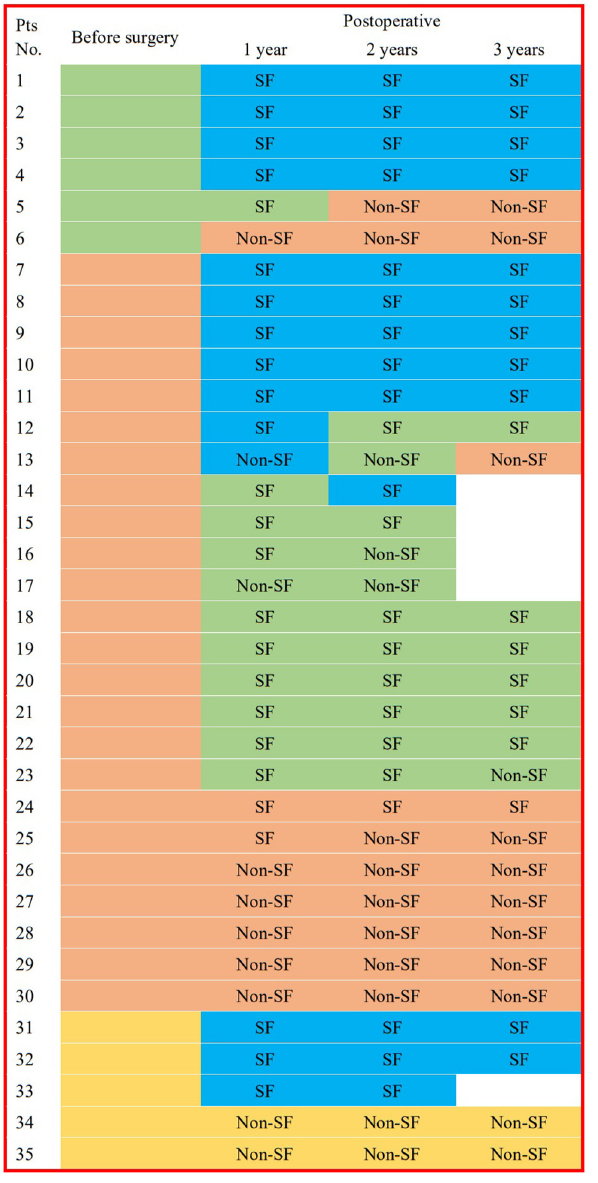
reviewed the recordings. The results of interictal EEG were divided into four groups: non-interictal discharge (IID) (without interictal epileptiform discharges, IIDs) ( Figure 1B ,B3), focal IID (unique unilateral focal IID with or without generalized IID) ( Figures 1A ,A1,A2, 2 ), multifocal IID (two or more independent focal IID or unilateral IID with or without generalized